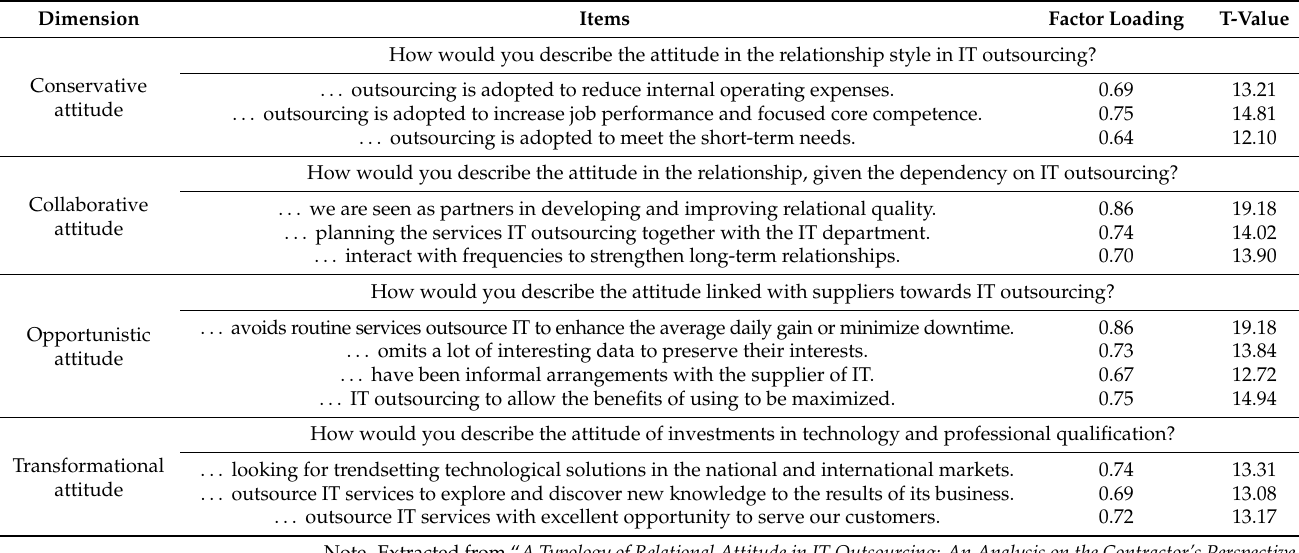
Table 3. Questionnaire items and related indices according to Poleto et al. [29]. Items